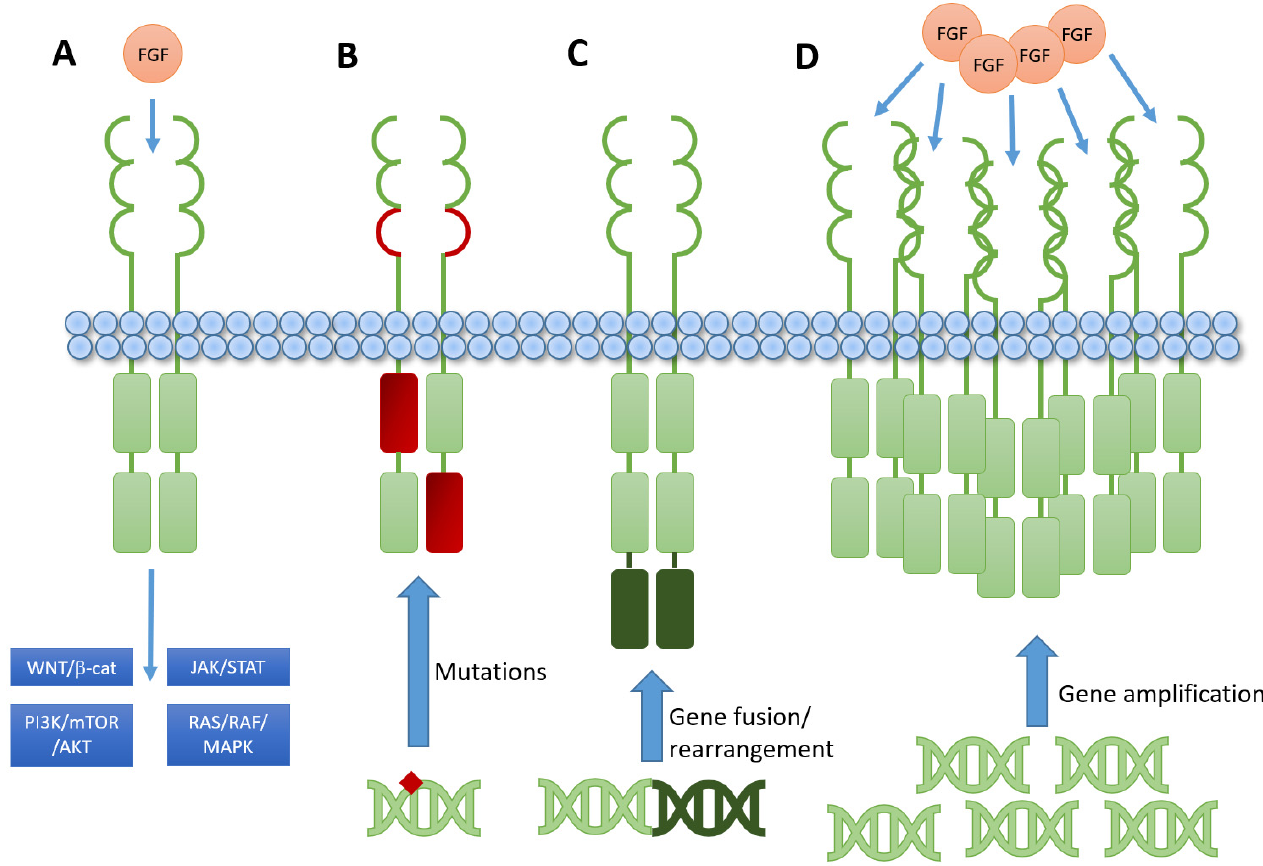
Figure 1. Schematic representation of FGFR signaling and impact of various alterations. ( A ) Physiologic signaling upon ligand binding leads to various downstream signaling cascades affecting cellular survival, growth, migration, metabolism and interaction with cellular microenvironment. ( B ) Point mutations (marked in red) lead to constitutive activation by either affecting the extracellular ligand-binding domain or the intracellular tyrosine kinase domains. Signaling becomes independent of FGF ligand binding. ( C ) Gene fusions, rearrangements or translocations on DNA level (marked in dark green) lead to ligand-independent constitutive activation of the kinase domains by adding alternative kinase elements. ( D ) Gene amplification by DNA copy number alterations leads to higher expression of the receptor, providing more opportunities for ligands to bind and to activate the signaling cascade. It is noteworthy that all shown alterations also lead to increased mRNA expression levels but not all alterations lead to receptor overexpression. AKT: synonymous Protein Kinase B; β -cat: β -catenin; FGFR: fibroblast growth factor receptor; JAK: janus kinase; MAPK: mitogen-activated protein kinase; mTOR: mammalian/mechanistic target of rapamycin; PI3K: phosphoinositide-3-kiase; RAF: rapidly accelerated fibrosarcoma; RAS: rat sarcoma; STAT: signal transducer and activator of transcription; WNT: wingless and Int-1.